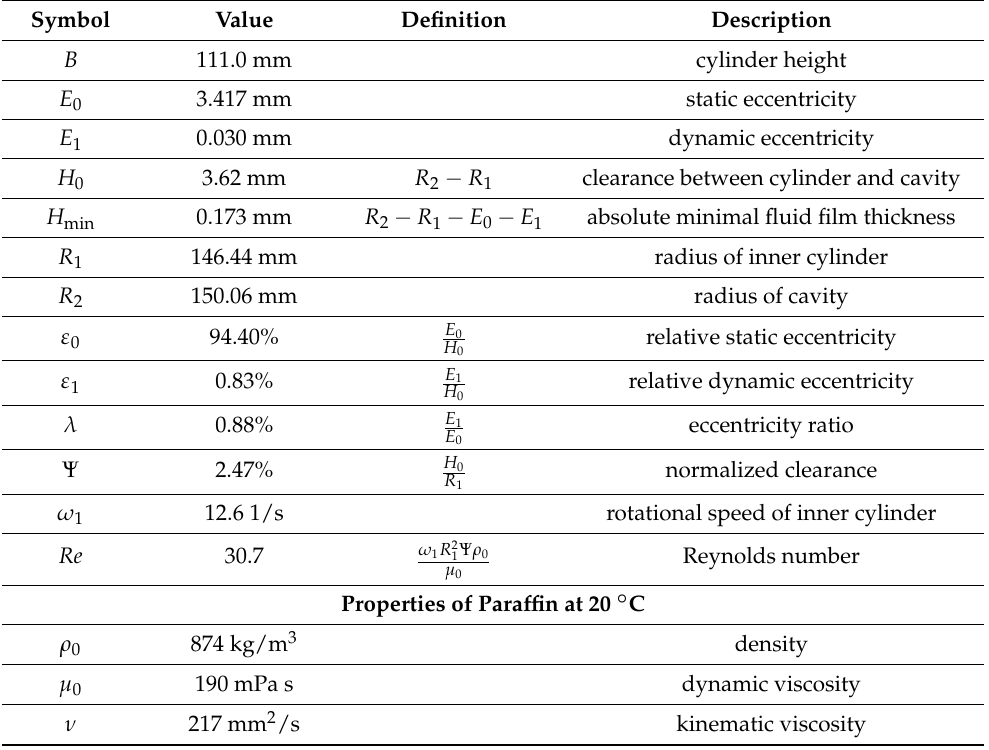
Table 2. Physical parameters of the